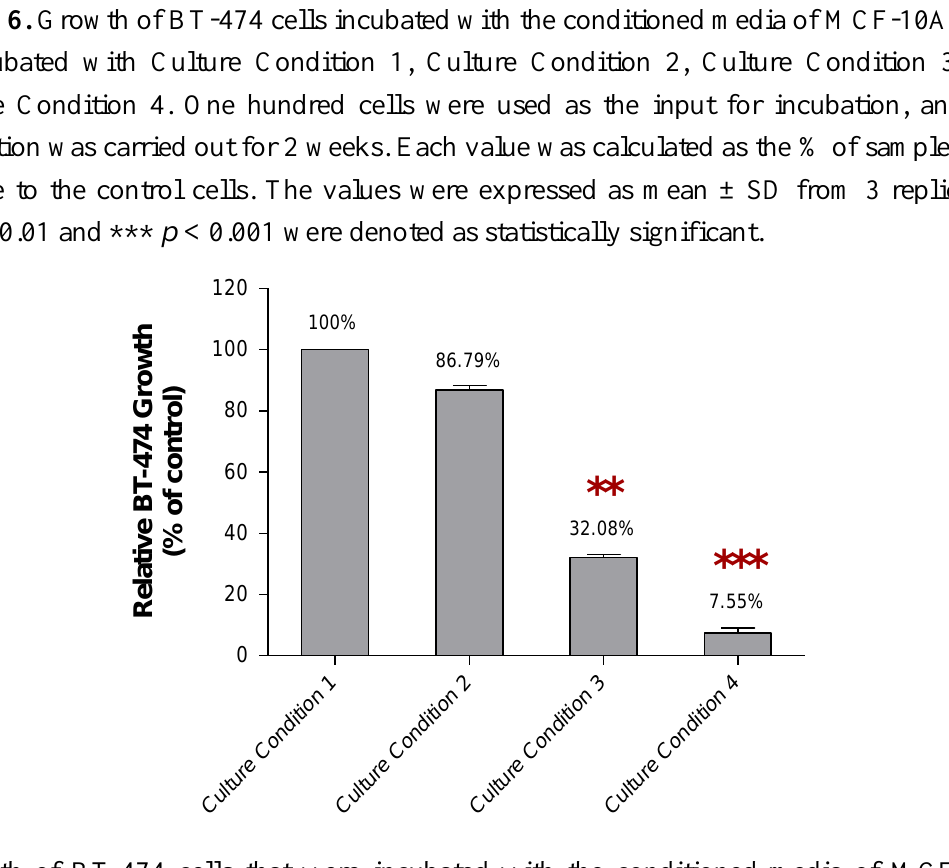
Figure 6. Growth of BT-474 cells incubated with the conditioned media of MCF-10A